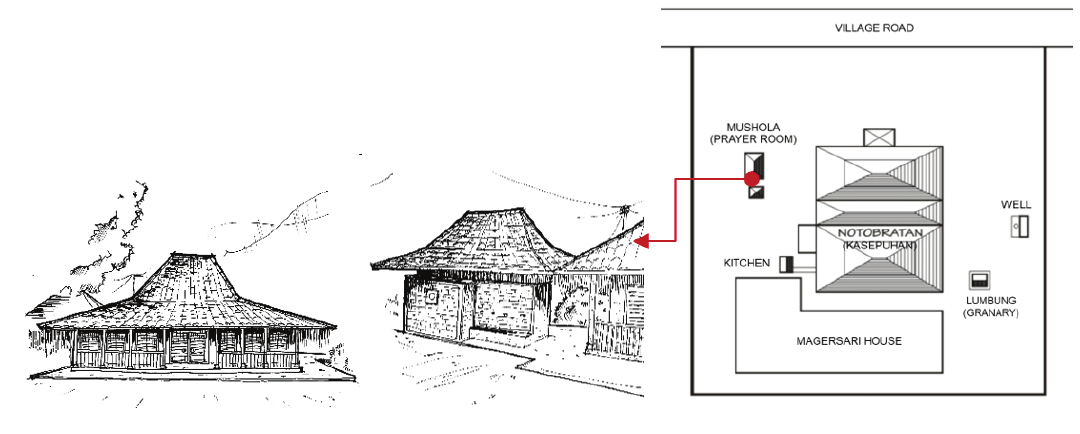
Figure 9. From left to the right: The former function was a guesthouse, but now it is a praying room ( mushola ); a new ablution place was built to complete the mushola ; site plan of Notobratan/ Kasepuhan (source: Survey,